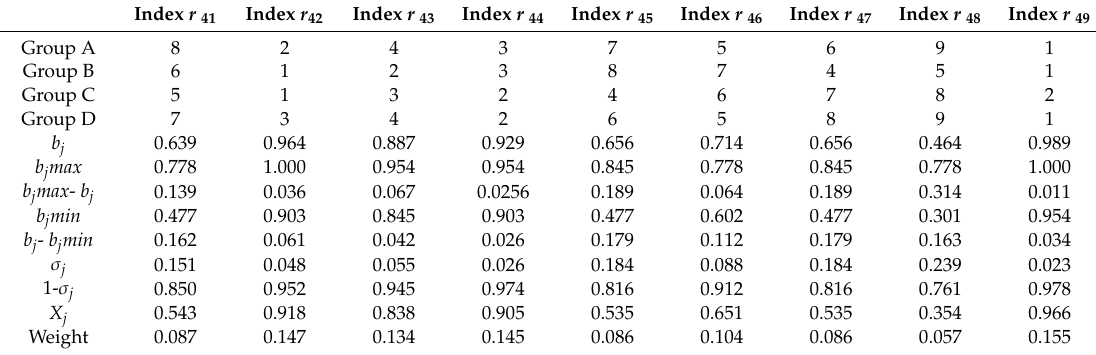
Table A5. Weight distribution of the second grade indexes of r